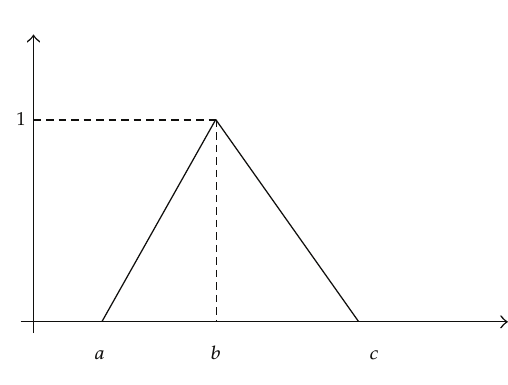
Figure 1: Triangular fuzzy